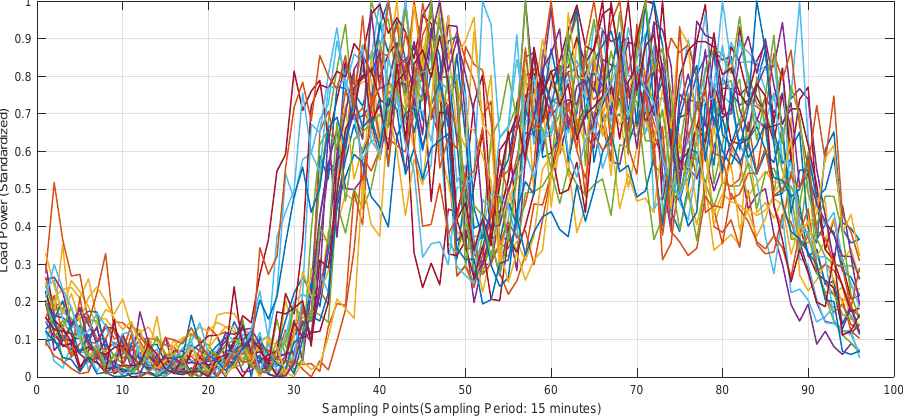
Figure 7. Load curves of 30 customers in Category 2.